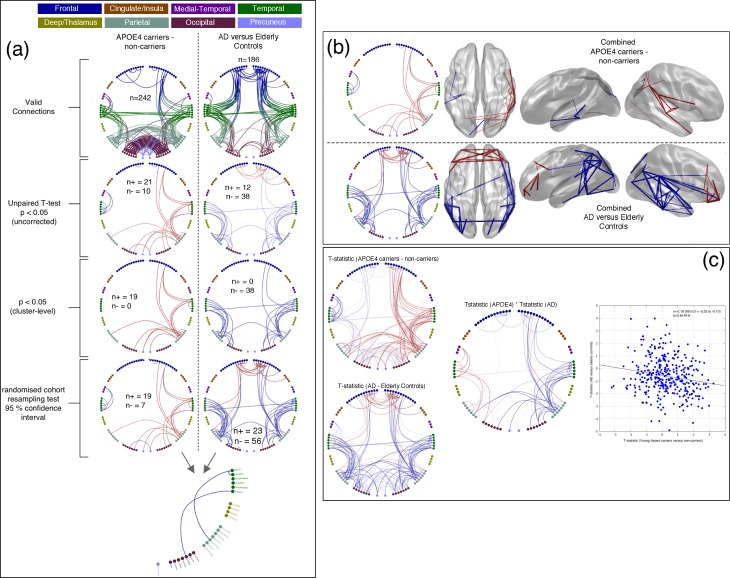
Comparison of connectivity differences in the two experiments, assessed using the Combined connectivity maps.(a) Replotting of the results for the Combined maps, extracted from Figure 1 and Figure 2 and displayed in the same format. At the bottom of this panel, a conjunction analysis is shown in which connections that meet the 95% confidence criterion for both experiments are displayed. Three connections survive this test and are shown in blue to reflect the fact that the effects have opposite sign (see Table 2 for more details). (b) A comparison of connections surviving a 95% confidence interval threshold, estimated using cohort resampling, for the APOE-ɛ4 versus young controls experiment (top row) and the AD versus elderly controls experiment (bottom row). Here we display the thresholded connections on both the circle plots (left column) and three views of a template brain (columns 2–4). (c) A direct comparison of effect sizes. In the left column, unthresholded t-statistics are displayed for the two experiments, with the opacity of the lines reflecting the magnitude of the t-statistic. In the middle, the two sets of t-statistics are multiplied together for display. In this panel, strong lines represent connections with high t-statistics for both the APOE-ɛ4 experiment and the AD experiment, with blue colours representing connections which show opposite effect directions for example hyperconnectivity in APOE-ɛ4 and hypoconnectivity in AD. In the right panel, the scatter plot shows the effect-size (i.e. unpaired t-statistic, thresholded at p<0.05 uncorrected) for the AD versus elderly control experiment, plotted against the effect-size for the APOE-ɛ4 carriers versus non-carriers experiment. A clear negative relationship is observed. Data and scripts needed to generate this figure can be found at http://dx.doi.org/10.17605/OSF.IO/E4CJX.